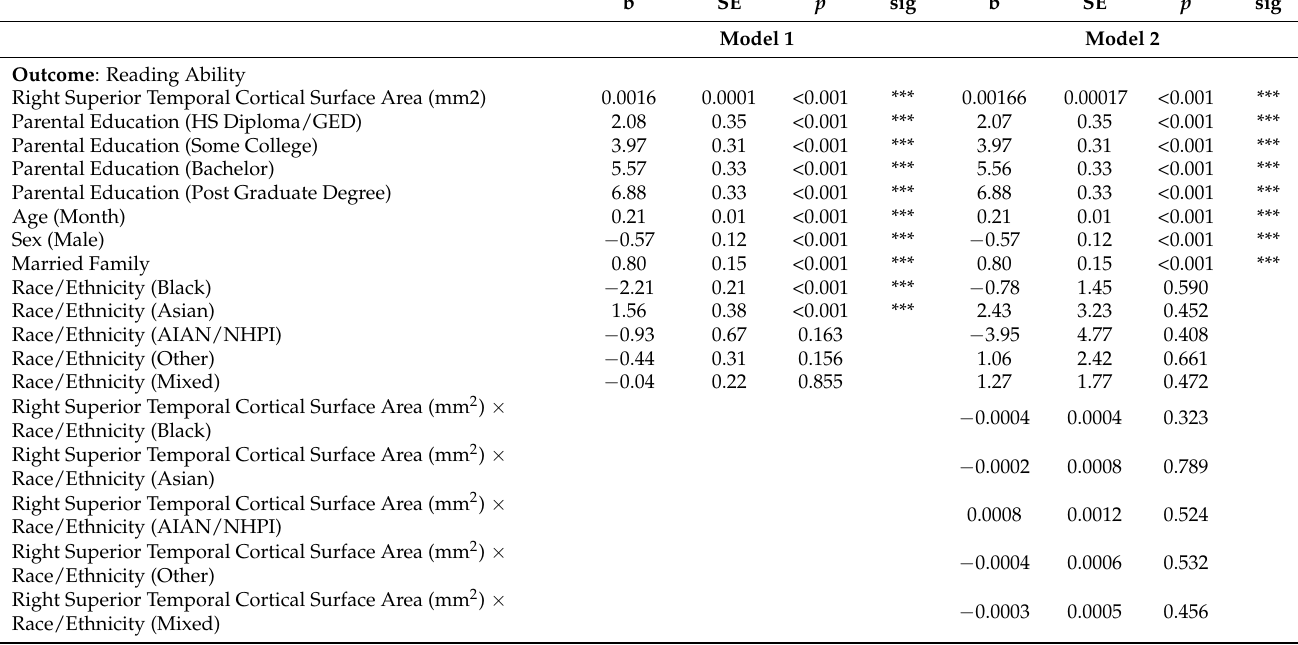
Table 5. Summary of mixed-effects regression models on the association between the right superior temporal cortical surface area and reading